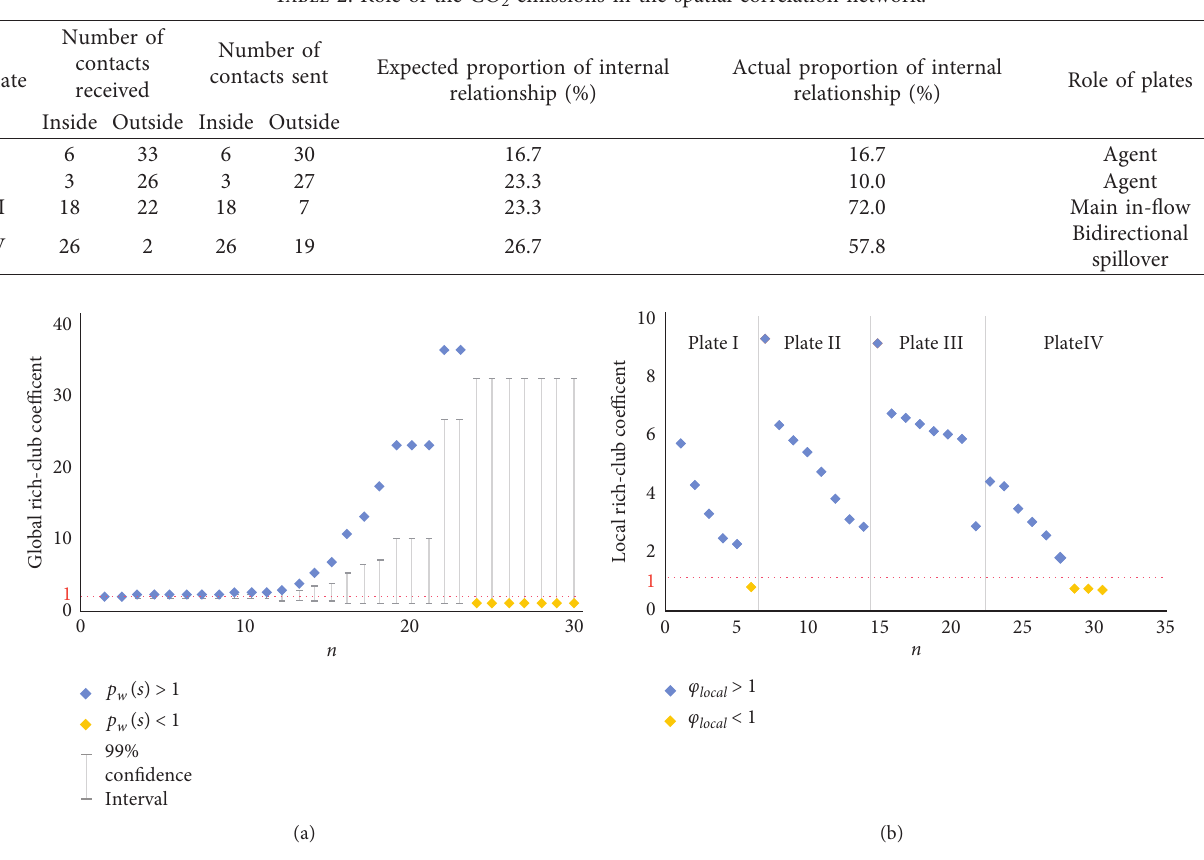
Figure 6: CO 2 emission network rich-club global coefficient (a) and local coefficient change trend (b). Note: N represents the number of random networks in Figure 6(a), and the judgment basis for defining rich nodes is the total strength of the nodes’ external connections.